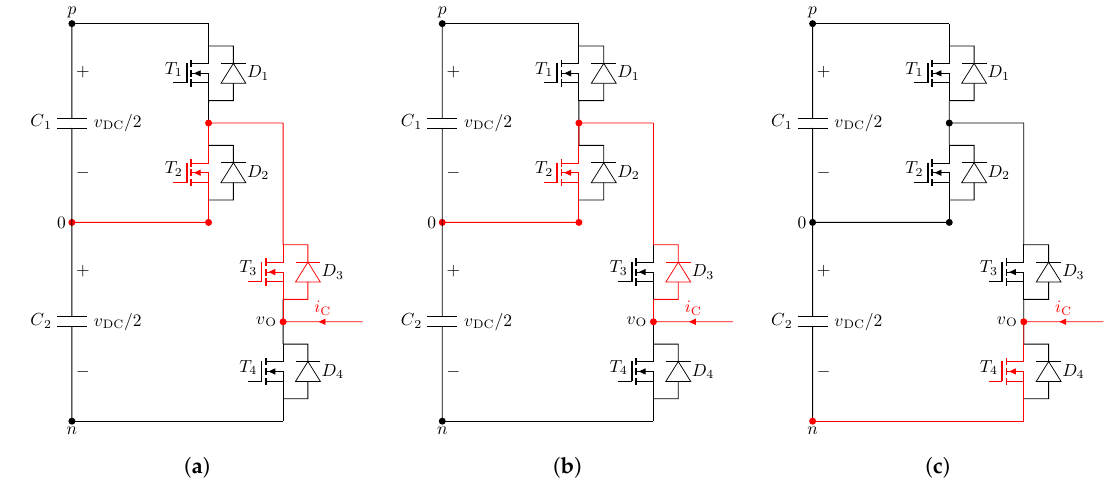
Figure 9. Current commutation, transition from switching state 0 to n for I C < 0. Current flow depicted in red. ( a ) Switching state 0 . ( b ) Blanking time (between T3 and T4 ) interval. ( c ) Switching state n